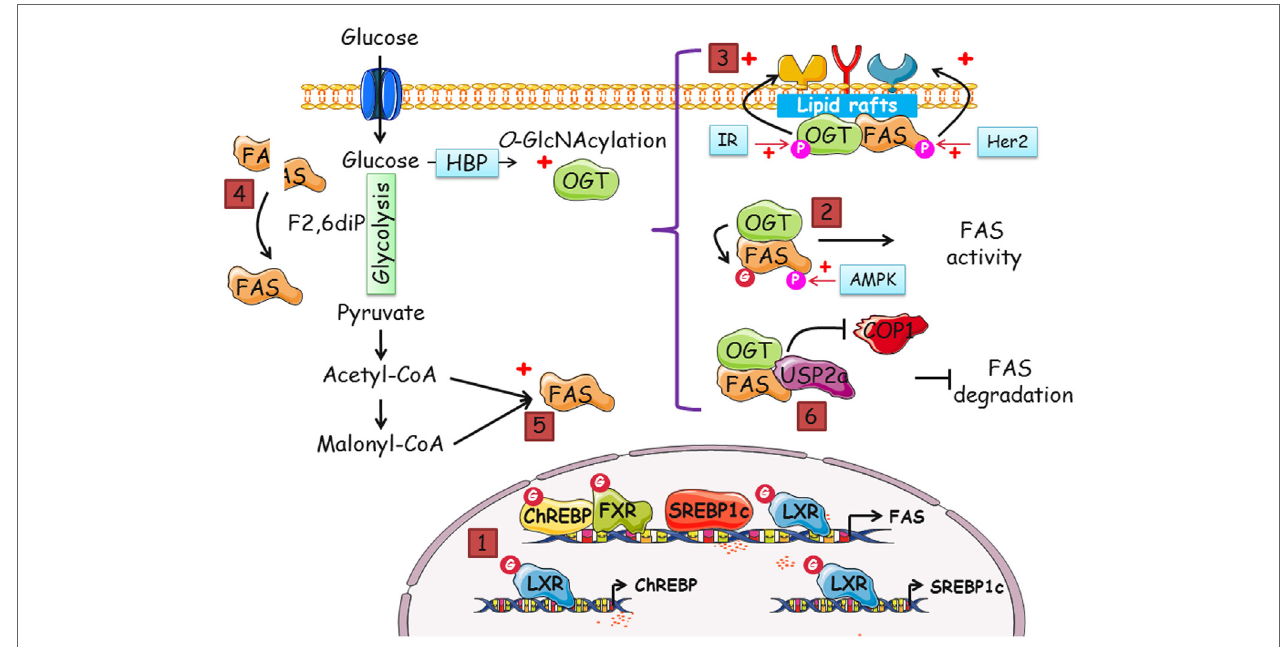
FiGUre 2 | Many putative pathways exist to regulate FAs by OGt and O -GlcNAcylation, and vice versa. Increased- O -GlcNAcylation and FAS overexpression are two features of cancer cells. In this perspective, we gathered data that suggest that a dialog between OGT and FAS potentiates cell proliferation. The different modes by which FAS and OGT might interact are the following: (1) indirectly, FAS mRNA level is regulated by O -GlcNAcylation. The transcription of FAS is coordinated by four transcription factors, ChREBP, SREBP1c, FXR, and LXR. SREBP1c and ChREBP are themselves regulated by LXR in an O -GlcNAcylation- dependent manner. The activity of ChREBP, FXR, and LXR is directly linked to their O -GlcNAcylation status. (2) There are few descriptions of the modification of FAS by phosphorylation but a complex interplay between O -GlcNAcylation and phosphorylation cannot be discarded. (3) In cancer cells, both FAS and OGT are upregulated. It is also known that the enzymes are resident in lipid rafts, platforms of signal transduction and cell signaling. Thus, FAS and OGT might be interacting partners in lipid microdomains. FAS may contribute to the interaction of OGT with a specific subset of fatty acids of lipid microdomains, especially phosphoinositides, and, in turn, OGT may upregulate FAS activity. Consequently, receptor tyrosine kinases should cluster and increase the activation of signaling pathways and cell proliferation. (4) FAS homodimer assembly is F2,6BP dependent. F2,6BP also controls the oligomerization of PFK-1, the rate-limiting enzyme of glycolysis (63). O -GlcNAcylation of PFK-1 at S529 impinges on the binding site of F2,6BP and negatively regulates its activity. By contrast, we speculate whether O -GlcNAcylation favors FAS dimerization and activity. (5) The increased-flux of glucose uptake observed in cancer cells enhances the production of acetyl-CoA and malonyl-CoA, the substrates of FAS, and UDP-GlcNAc (in parallel with the accelerated-flux of glutamine in tumor cells), the donor of GlcNAc for the O -GlcNAcylation processes. It can be envisioned that one or several catalytic activities of FAS are directly under the control of OGT through their O -GlcNAcylation. Therefore, FAS might be controlled by glucose in two distinct ways: by enhancing the availability of substrates and by the posttranslational modification by O -GlcNAc moieties. (6) The O -GlcNAcylation of FAS may potentiate the interaction with the deubiquitinase USP2a and/or destabilize its interaction with the E3-ubiquitin ligase COP1, rendering the enzyme less sensitive to ubiquitin-dependent